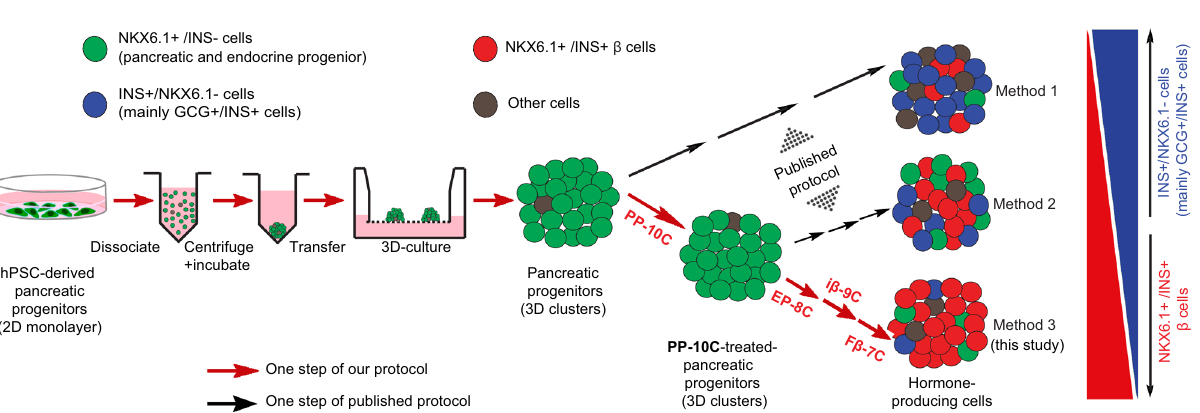
Fig. 5 A schematic diagram summarizing the discoveries revealed in this study. HPSC-derived PPs are dissociated and re-aggregated into PP 3D clusters by centrifuge and incubation in a V-shaped-bottom microplate and then transferred to the air – liquid interface. The PPs in 3D clusters mainly differentiate into β -cells after they are successively treated by PP-10C, EP-8C, i β -9C, and F β -7C. However, if other suboptimal conditions are employed, the yield of β - cells is signi fi cantly reduced, whereas that of the dual-hormonal GCG + /INS + cells